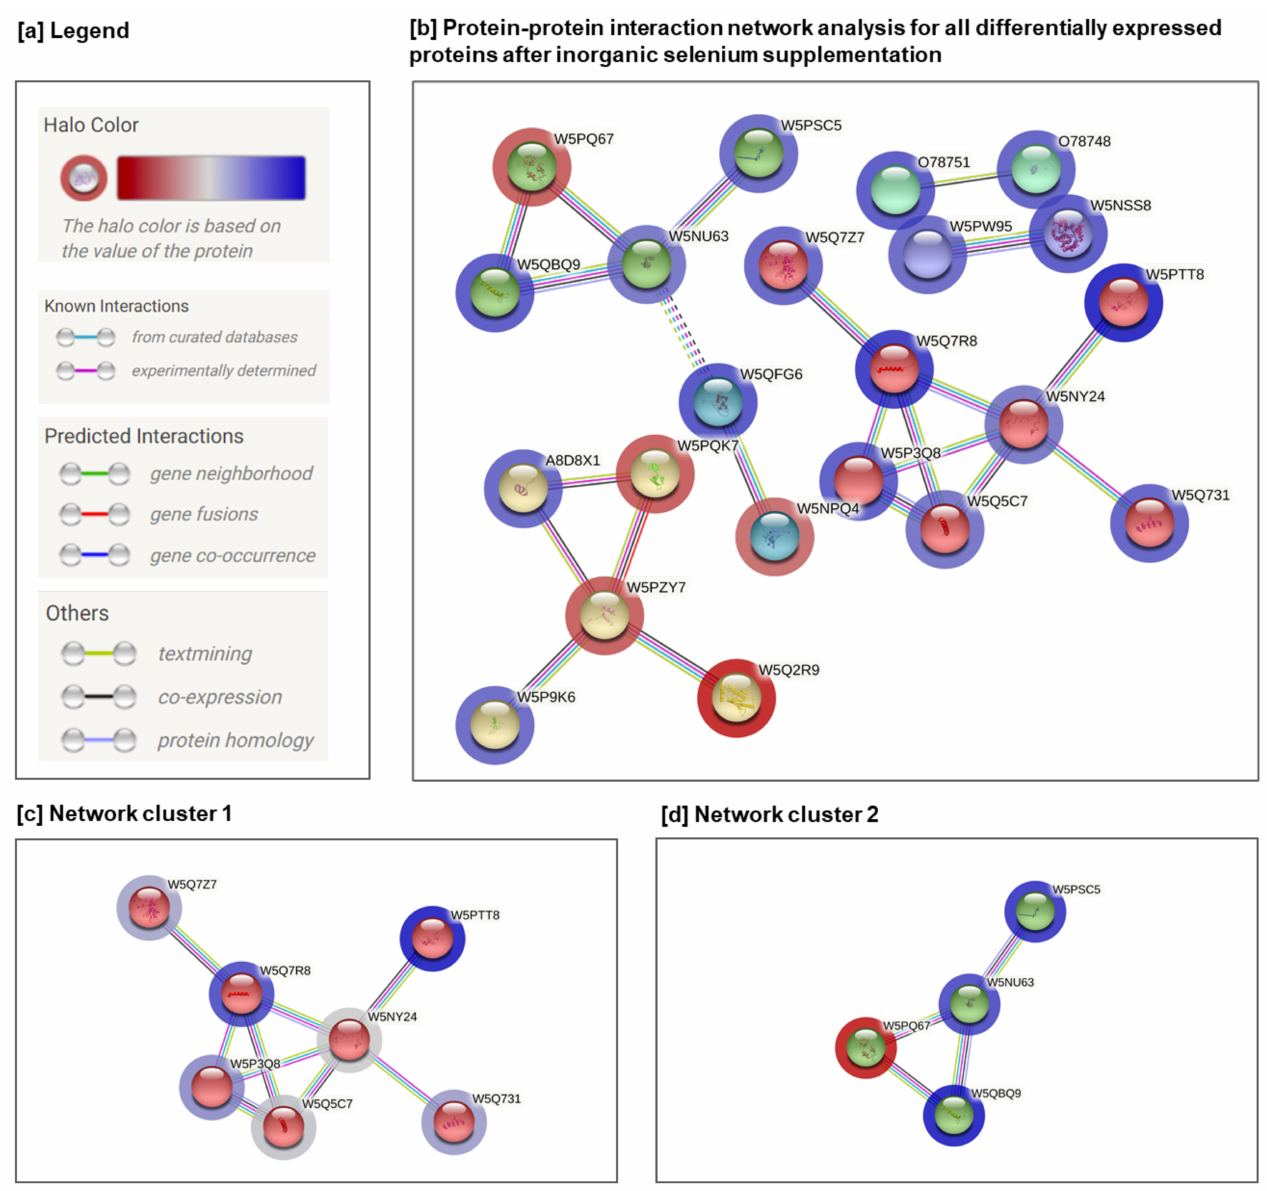
Figure 3. Protein-protein interaction network of differentially regulated proteins after inorganic sele- nium supplementation with the addition of 2% RO, 1% FO, 0.1% CA: ( a ) legend; ( b ) protein–protein interaction network analysis for all differentially expressed proteins; ( c , d ) two interactions between protein complexes from the STRING database formed by means of the Markov Cluster Algorithm. The number of lines represents the strength of predicted functional interactions between